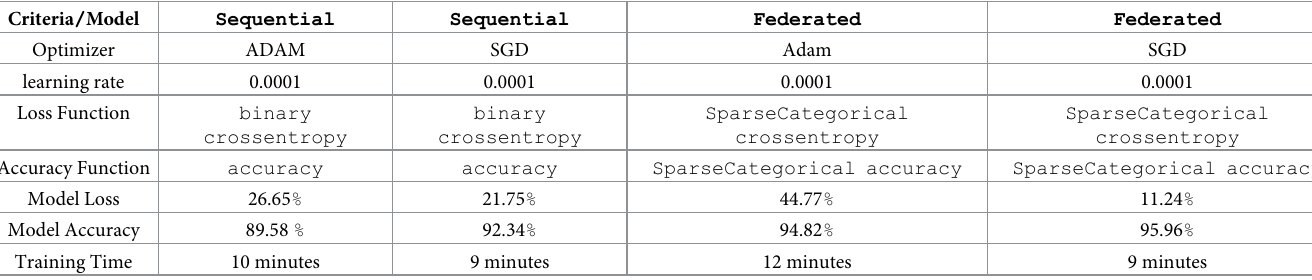
Table 3. Comparison between proposed models accuracy and loss on patient’s chest